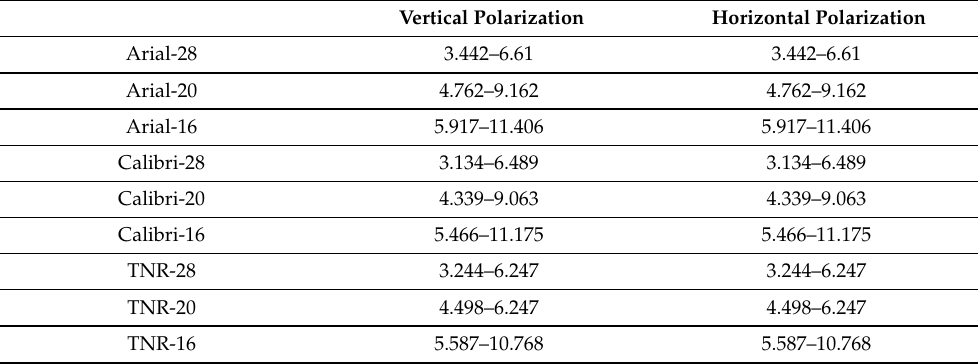
Table 8. Signature resonance frequencies for letter tag (cid:80) with various font types and